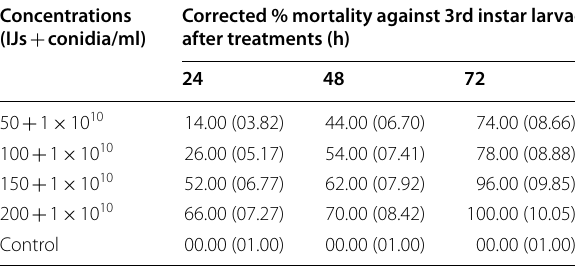
Figures in parentheses are transformed values (arc sine transformation) CD ( P